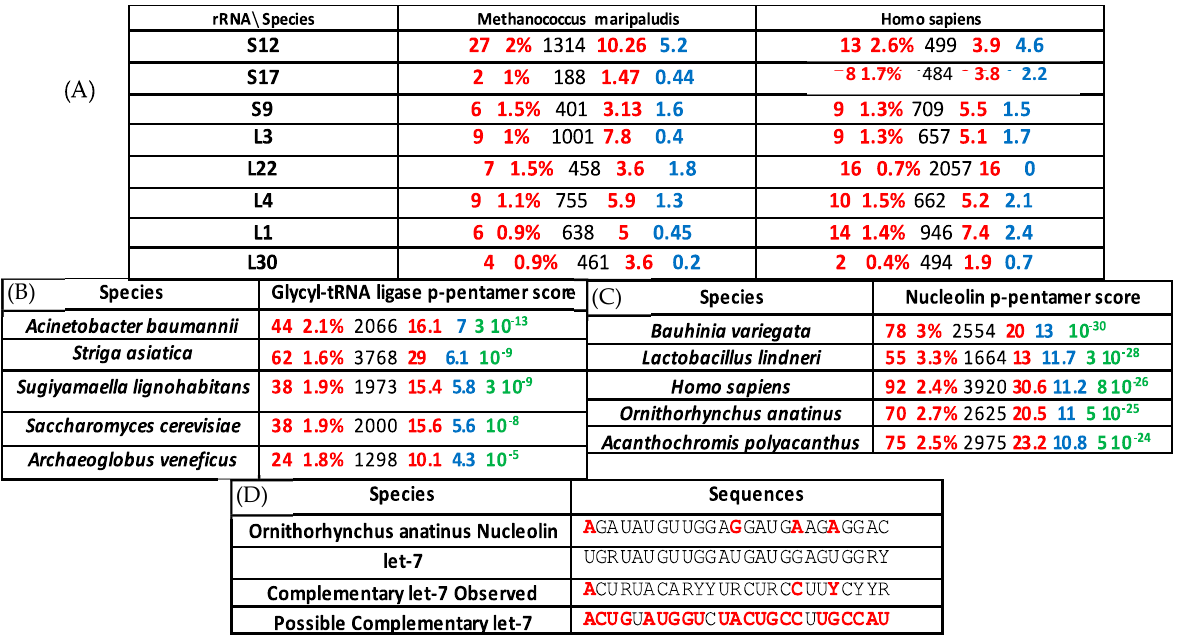
Figure 2. ( A ) Some of the ribosomal protein genes and RNAs in Caetano-Anollés’ order [33] with successive indications of the observed number P o of p-pentamers common with AL in their nucleotide sequence (red), their percentage inside the set of tall heir pentamers (red), their sequence size (black), the expected number P e (red), and the number of standard deviations between P o and P e (blue). ( B ) Same representation as in ( A ) for the Glycyl-tRNA ligase of various species, plus the probability to observe such P o ’s (green). ( C ) Same representation as in ( B ) for the nucleolin of various species. ( D ) Sub-sequence of the nucleolin gene of Ornithorhynchus anatinus matching with its mRNA inhibitor, the microRNA let7, whose complementary sequence contains parts from AL sequence (in red) (cf. Figure S1 in Supplementary Materials).